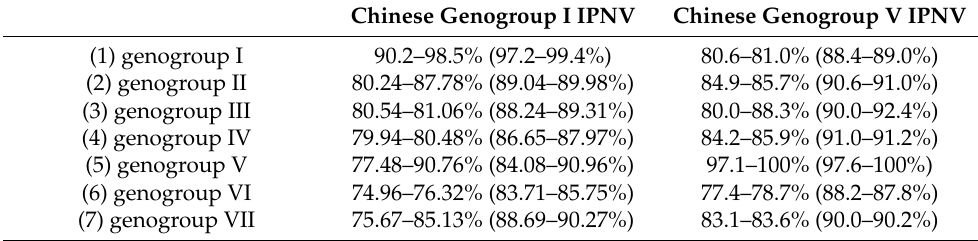
Table 4. Nucleotide (Amino acid) sequence identity of Chinese IPNV with other